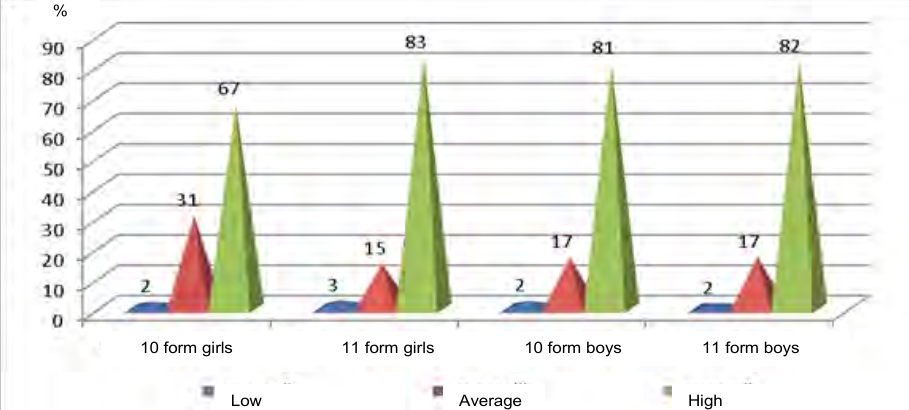
Fig.1. Level of senior pupils’ situational anxiety after physical fitness testing at physical culture